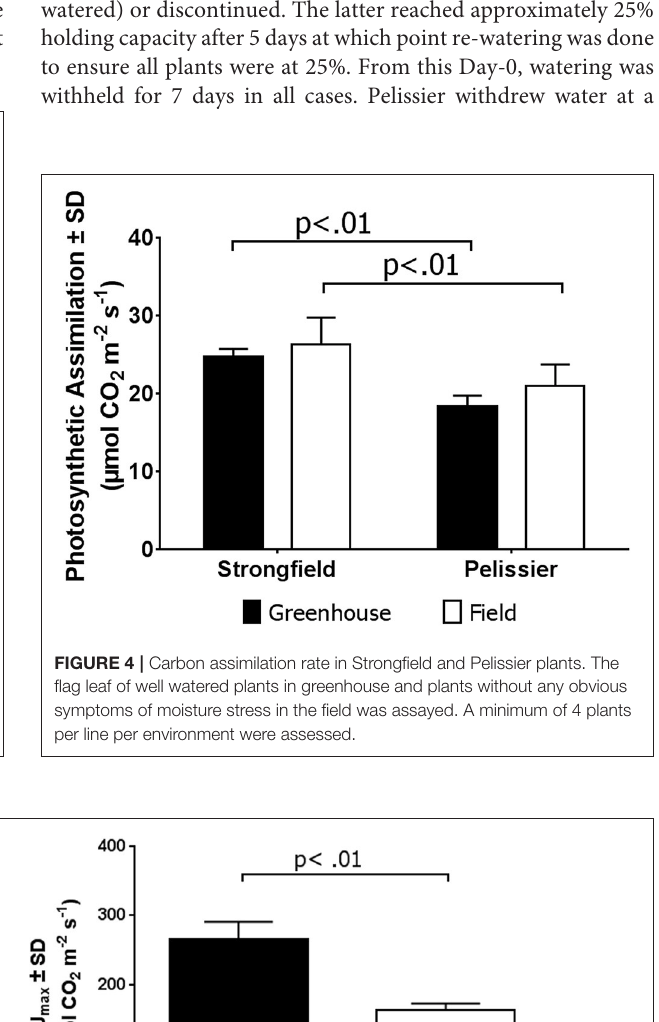
Frontiers in Chemistry |